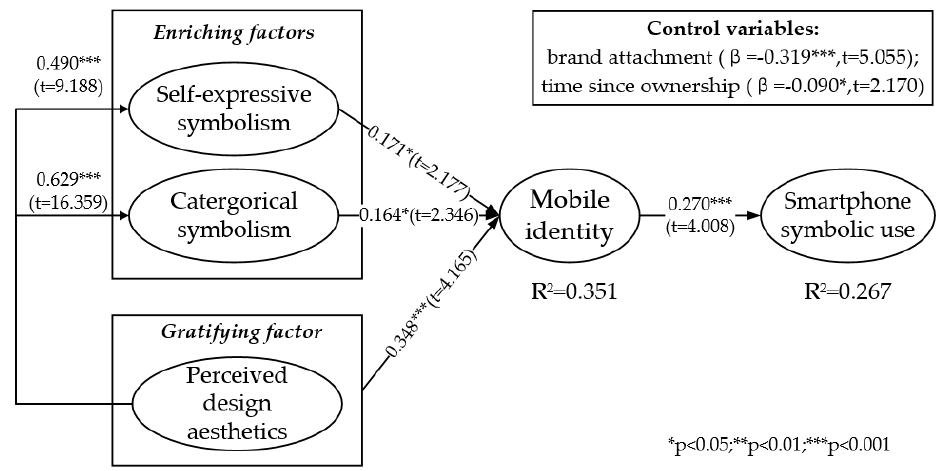
Figure 4. Structural model.